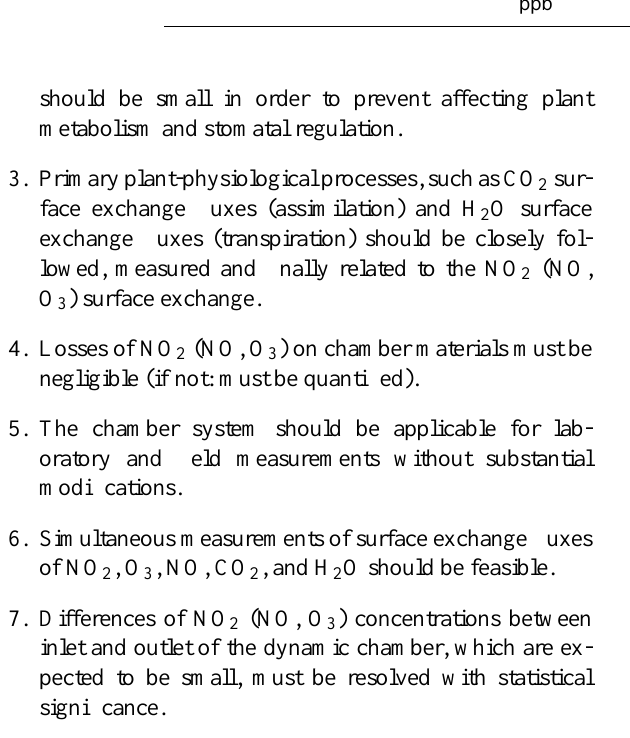
), where the precision of NO 2 concentration measure- 2